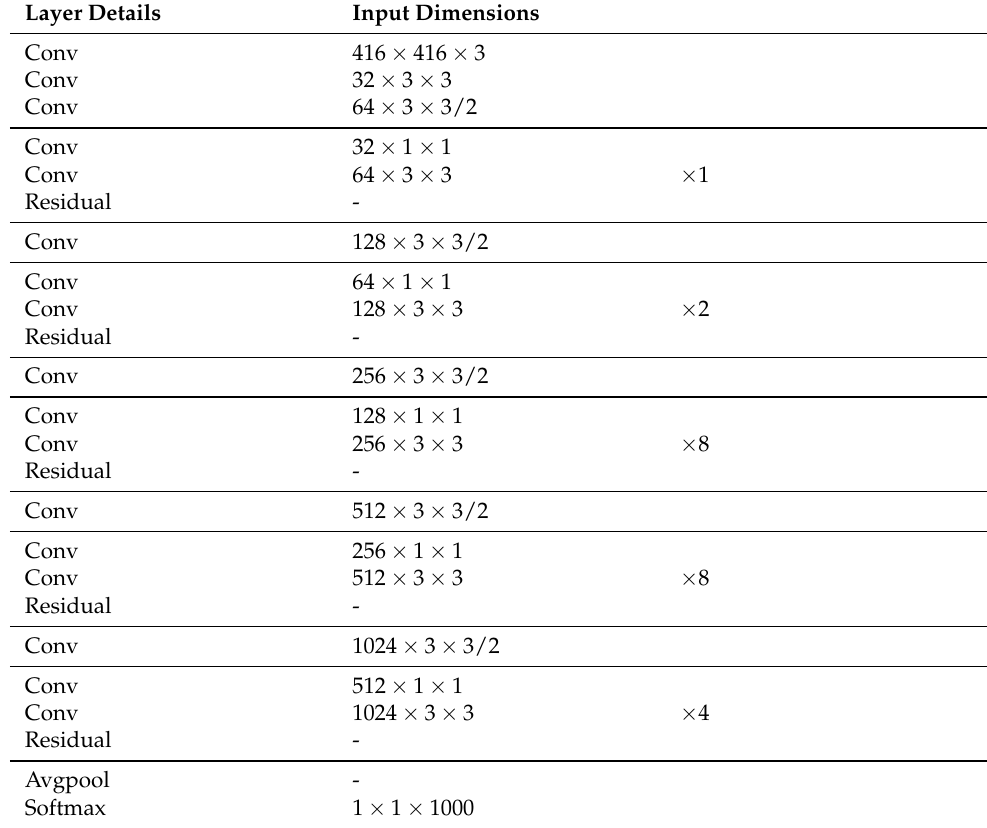
Table 1. CSPDarknet53